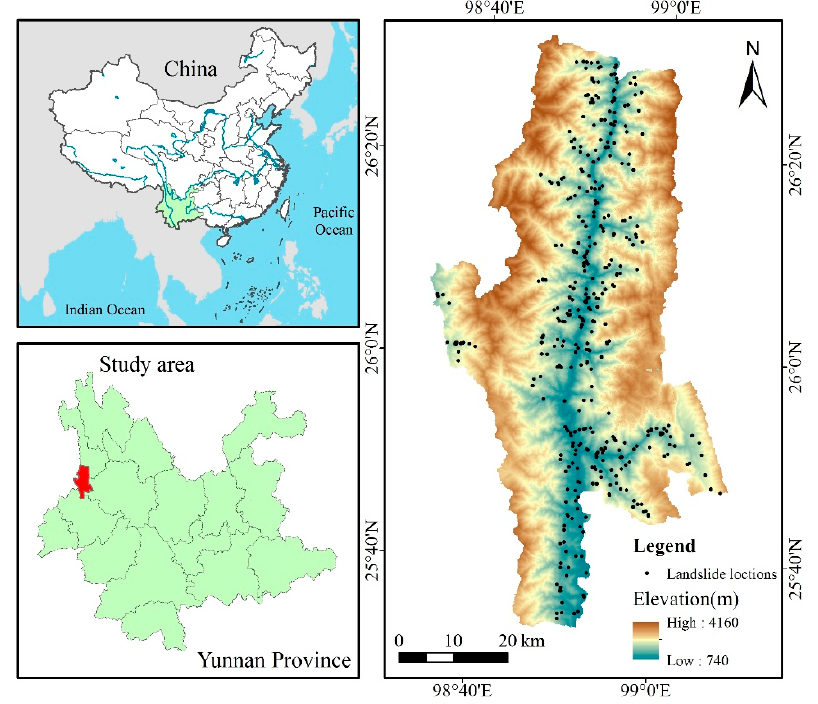
Figure 1. Geographical position of the study area and landslide inventory map.